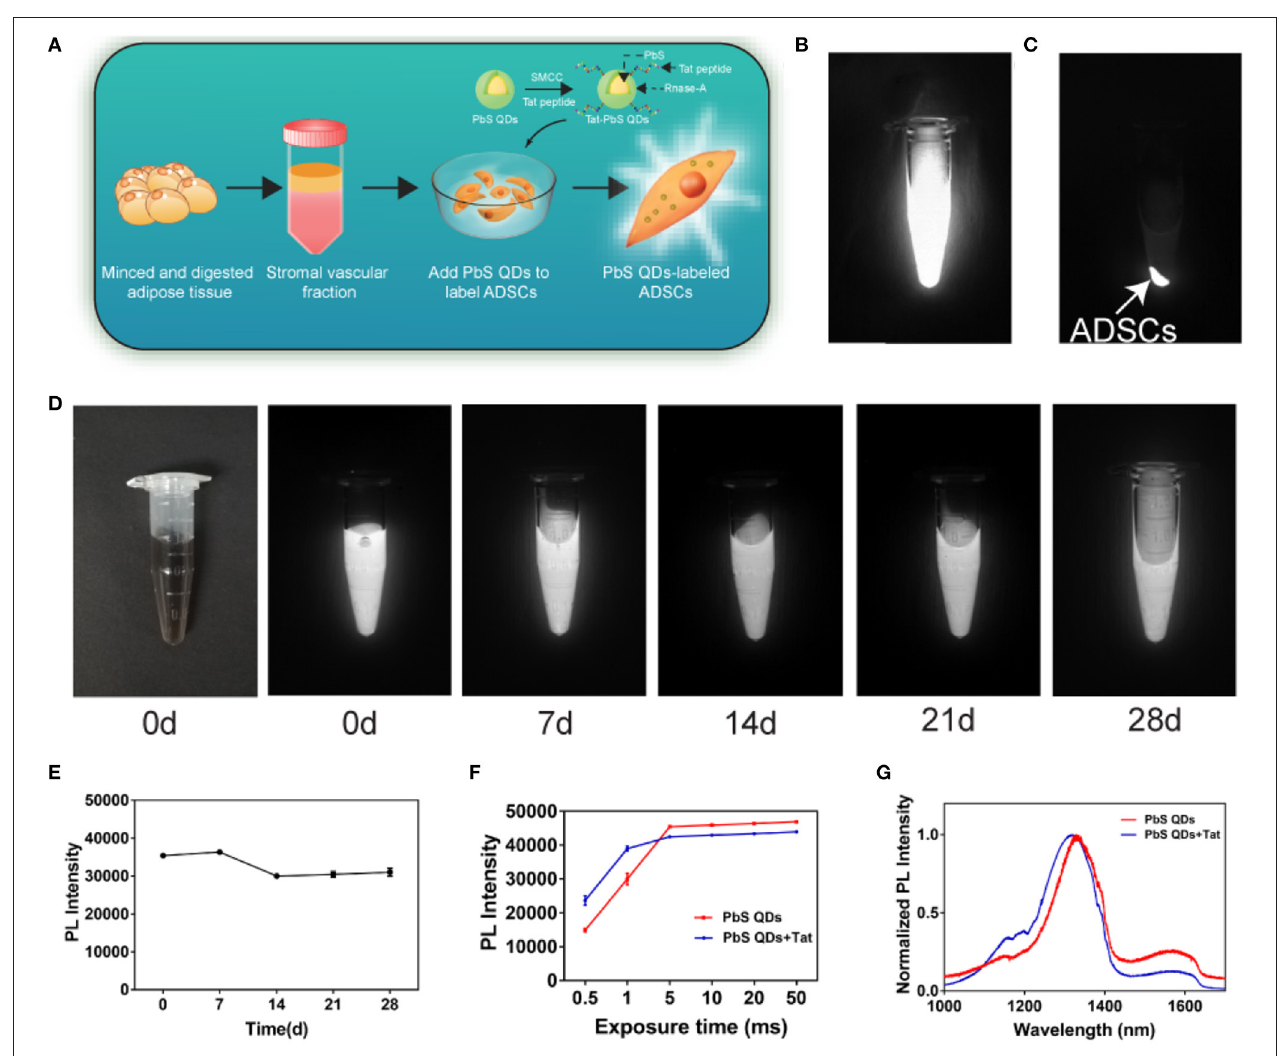
FIGURE 2 | Fluorescence properties of PbS QDs + Tat and the labeling of ADSCs. (A) Schematic of synthesis of PbS QDs + Tat and labeling of ADSCs. (B) NIR-II imaging of PbS QDs labeled ADSCs in the state of suspension and (C) after centrifugation. (D) NIR-II imaging ( λ ex: 808nm, exposure time: 1ms) of the same PbS QDs + Tat in a time course (0, 7, 14, 21, and 28 d post-preparation). (E) PL intensity of the same PbS QDs + Tat after storage. (F) PL intensity of PbS QDs and PbS QDs + Tat under different exposure time. (G) Normalized PL spectra of PbS QDs and PbS QDs +